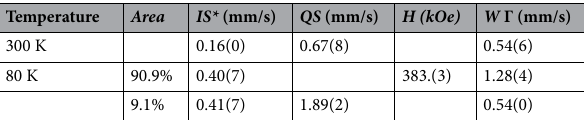
Table 2. Mössbauer data at 300 K and 80 K for BSFCO